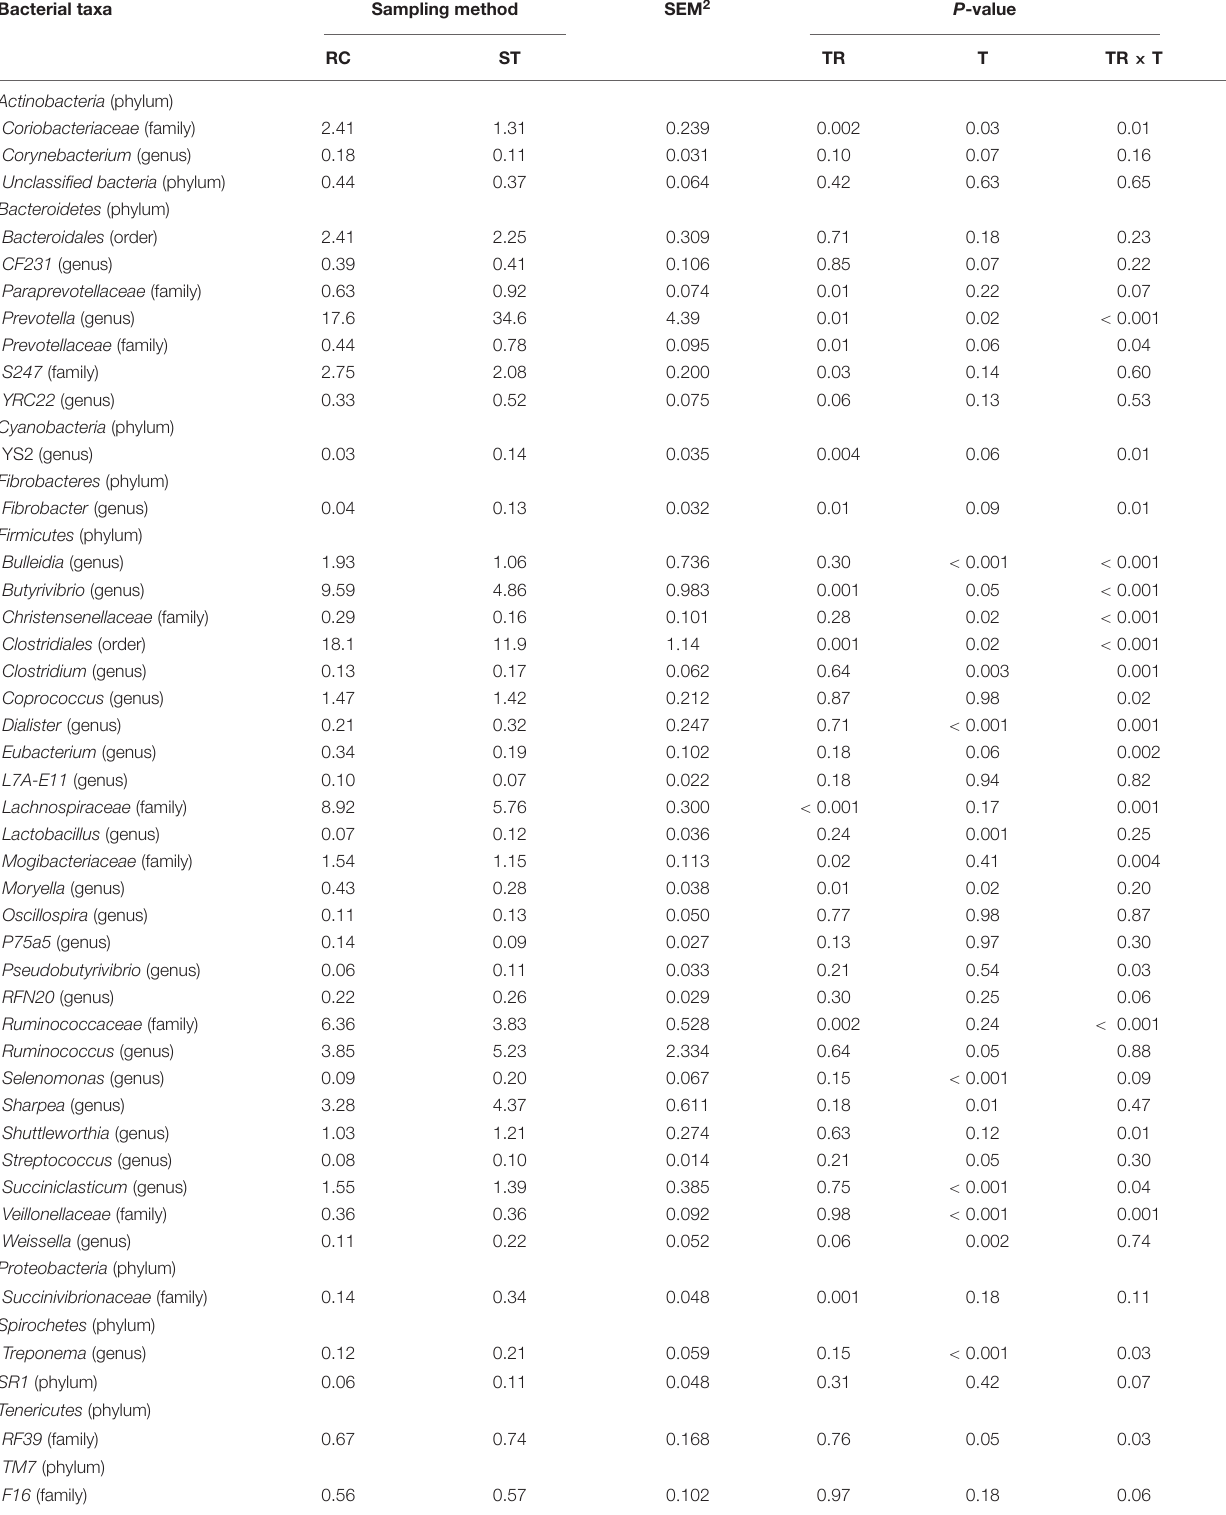
TABLE 2 | Effect of sampling techniques (rumen cannula, RC, vs stomach tube, ST) on bacterial composition (%) 1 in lactating dairy cows. Bacterial taxa Sampling